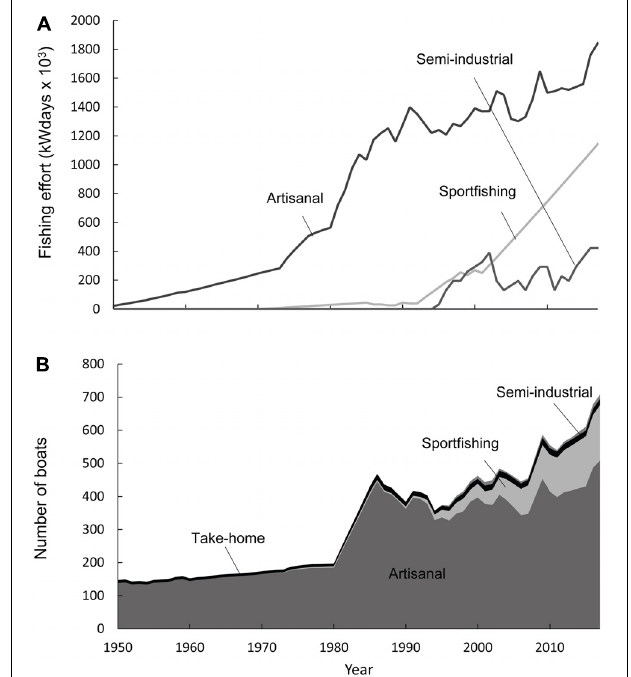
FIGURE 4 | Fishing effort for the domestic fisheries in the Seychelles from 1950 to 2017 as (A) effective fishing effort (fishing capacity); and (B) total number of vessels by sector. Take-home catch was estimated as a component of the artisanal fishery rather than an independent fishery so the effort for the take-home catch was not